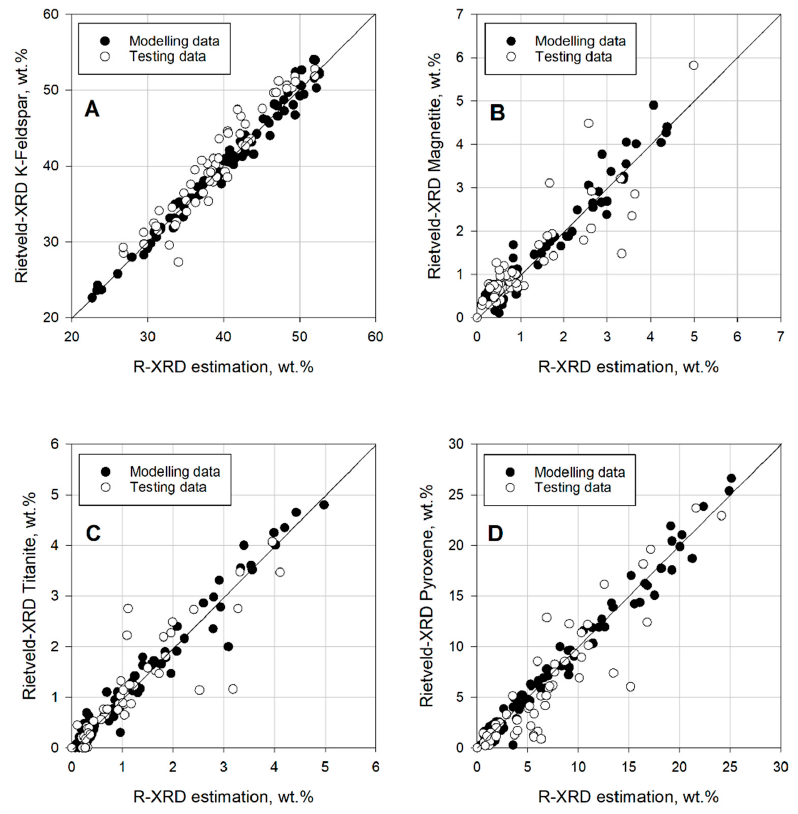
Figure 6. Comparison between R-XRD estimations ( x -axis) and measured ( y -axis) K-feldspar ( A ); magnetite ( B ); titanite ( C ); and pyroxene ( D ).